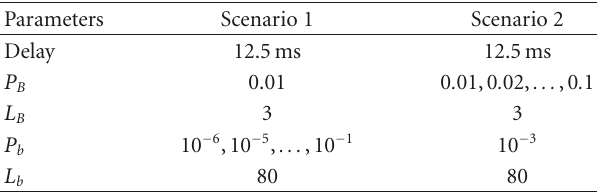
Table 3: Network settings.